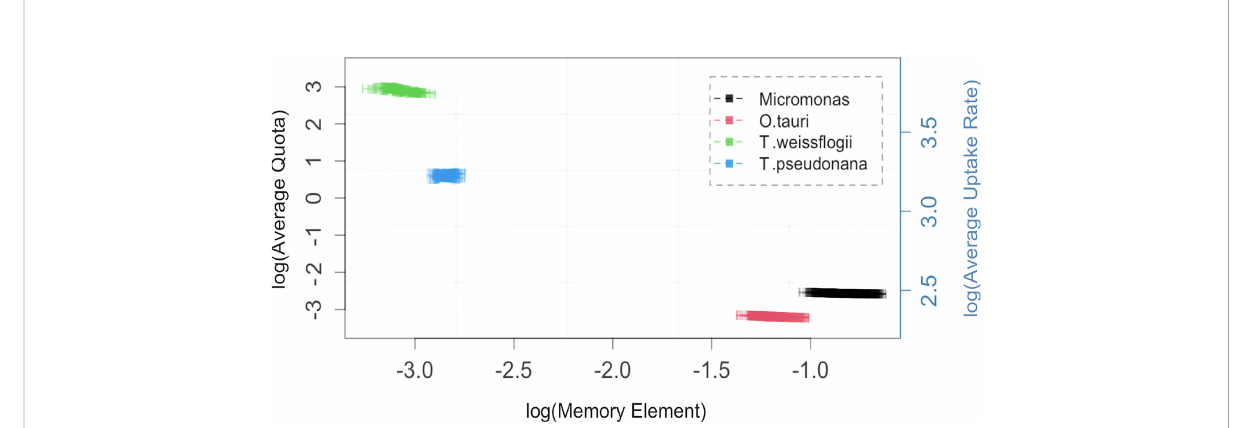
FIGURE 3 The memory element, a , (squares with 95% con fi dence interval) is negatively correlated with average quota and uptake rate for the four phytoplankton taxa studied. Replicates for each tax a are generated from 200 independent fi ts of the Monod-memory model to Droop model with parameters and initial values drawn from ranges given in Table S1 for each taxon. Note natural log scales on both